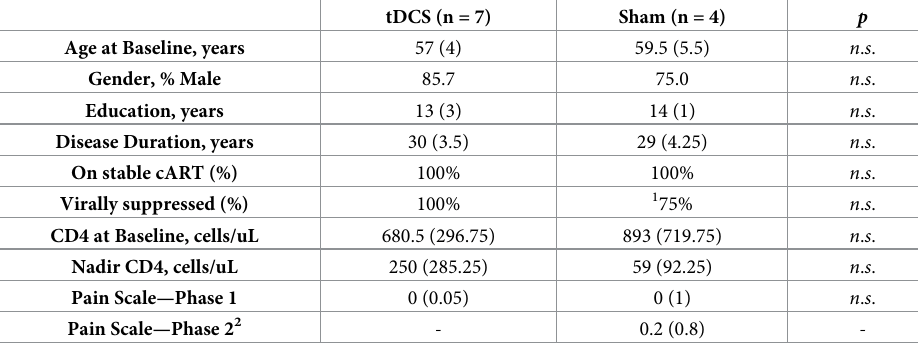
Table 1. The demographics and study assignment of the